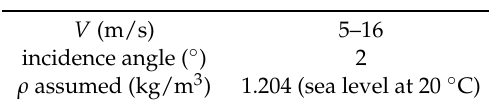
Table 3. Test conditions.